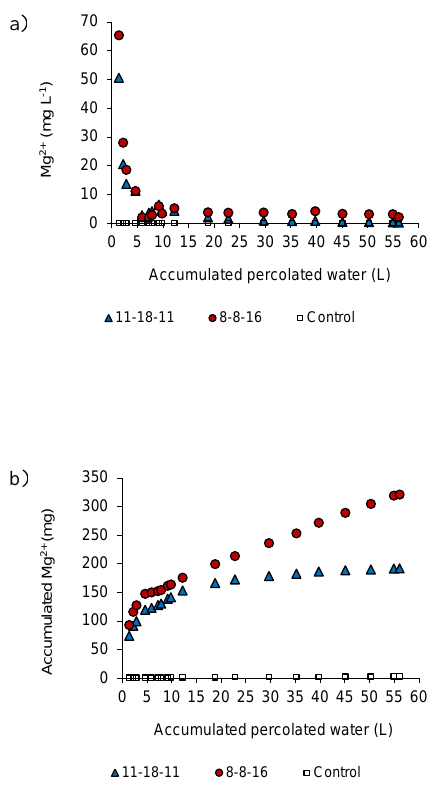
Figure 8. Magnesium concentrations in leachates (a) and accumulated Mg +2 losses (b) from fertilized and control columns along the experiment (average of three replicates).